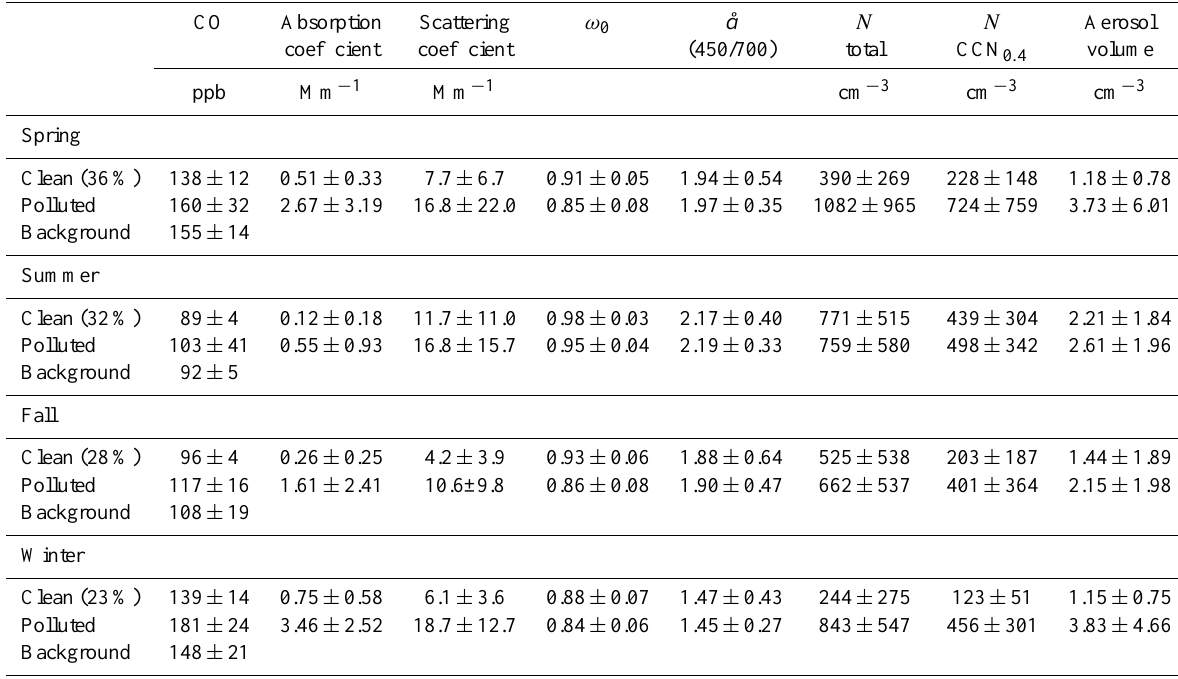
Table 3. Mean and standard deviation for CO, absorption coefficient, scattering coefficient, single scattering albedo, Ångström exponent, total aerosol number concentration, CCN 0 . 4 number concentration, and aerosol volume concentration for polluted and pristine air at ZOTTO (300m). The frequency of clean periods determined by the manual selection method is indicated in parentheses. CO Scattering ω 0 å N N Aerosol coefficient (450/700) total CCN 0 . 4